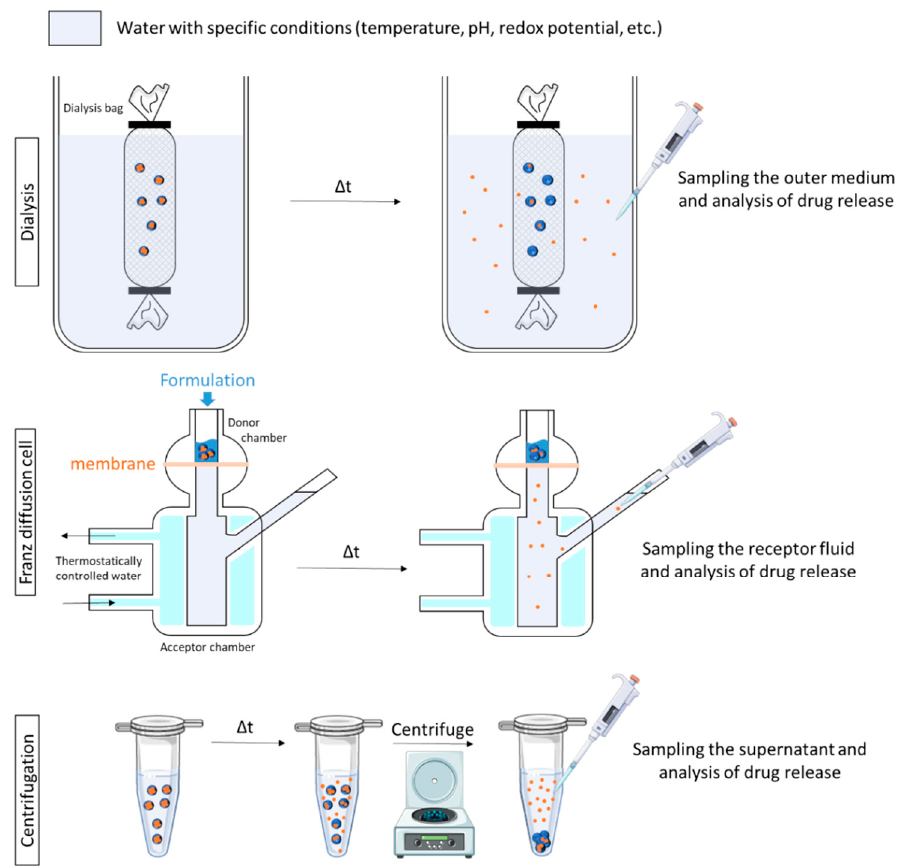
Figure 5. In vitro triggered drug release studies: methods used to separate the released drug from its smart system.